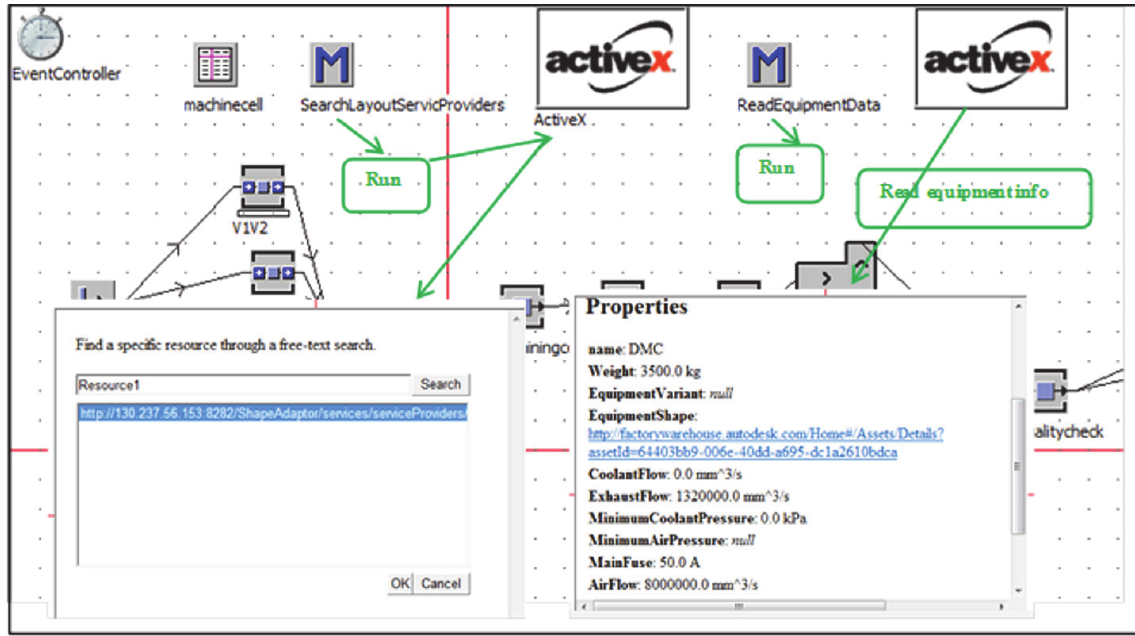
Figure 17: Plant Simulation uses the Activx interface to access to the Inventor